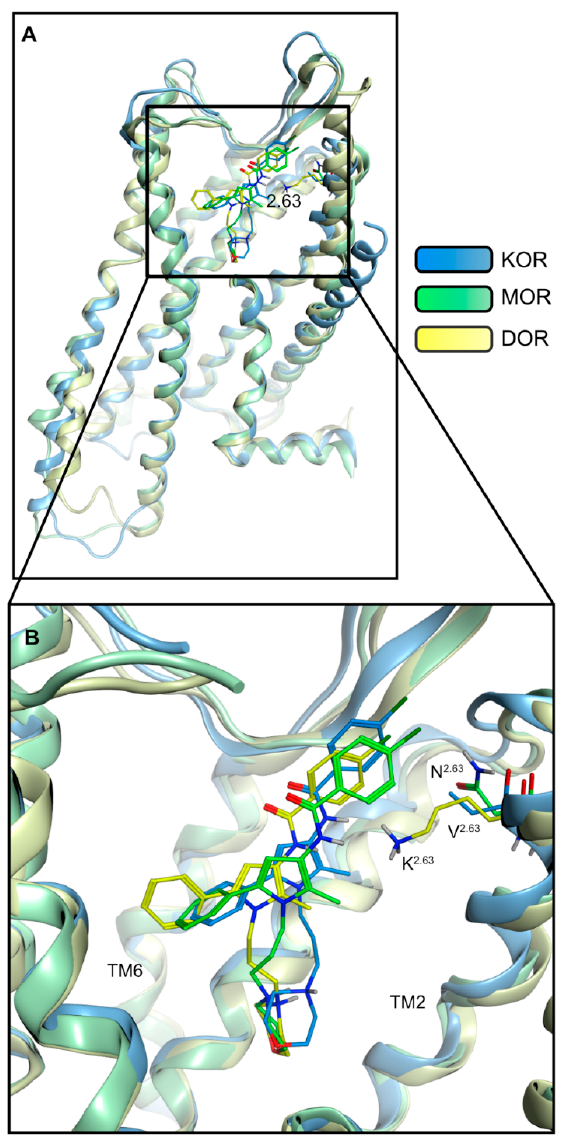
Figure 5. Binding mode of Compound A at the KOR, MOR and DOR. ( A ) Compound A binds within the orthosteric pocket in the extracellular half of the receptors. ( B ) Compound A shares an overall similar orientation within the receptors. The residues 7.28–7.41 are not shown for better visualiza ‐ tion.